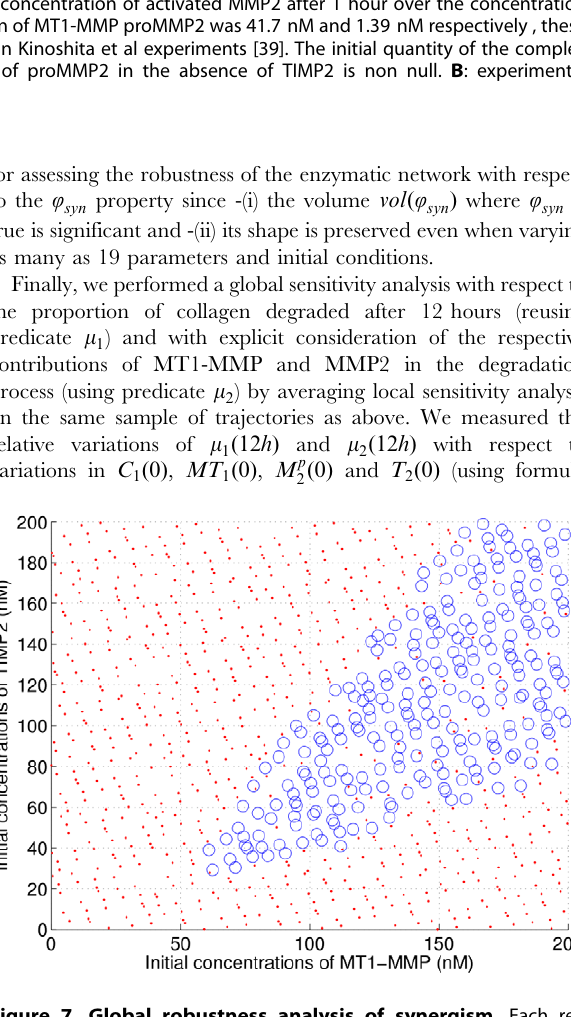
Figure 6. Values of initial pro-MMP2 and TIMP2 exhibiting Figure 7. Global robustness analysis of synergism. Each red w C 1 MT 1 and 90 percent of point corresponds to a trajectory for which Q syn is not satisfied and each synergism. In region C, we have C 1 M 2 d d the collagen is degraded after 12 hours (i.e. ev ½ 0,12 h ) ( m 1 ^ m 2 ) ). In D, we green circle corresponds to a trajectory satisfying Q syn . Note that the N ~ 1000 samples parameters represented on this figure are also have ev uniformly distributed in the other dimensions of the parameter space corresponding to varying initial concentrations of collagen C 1 and varying values of the kinetic chemical constants with 10% of their nominal